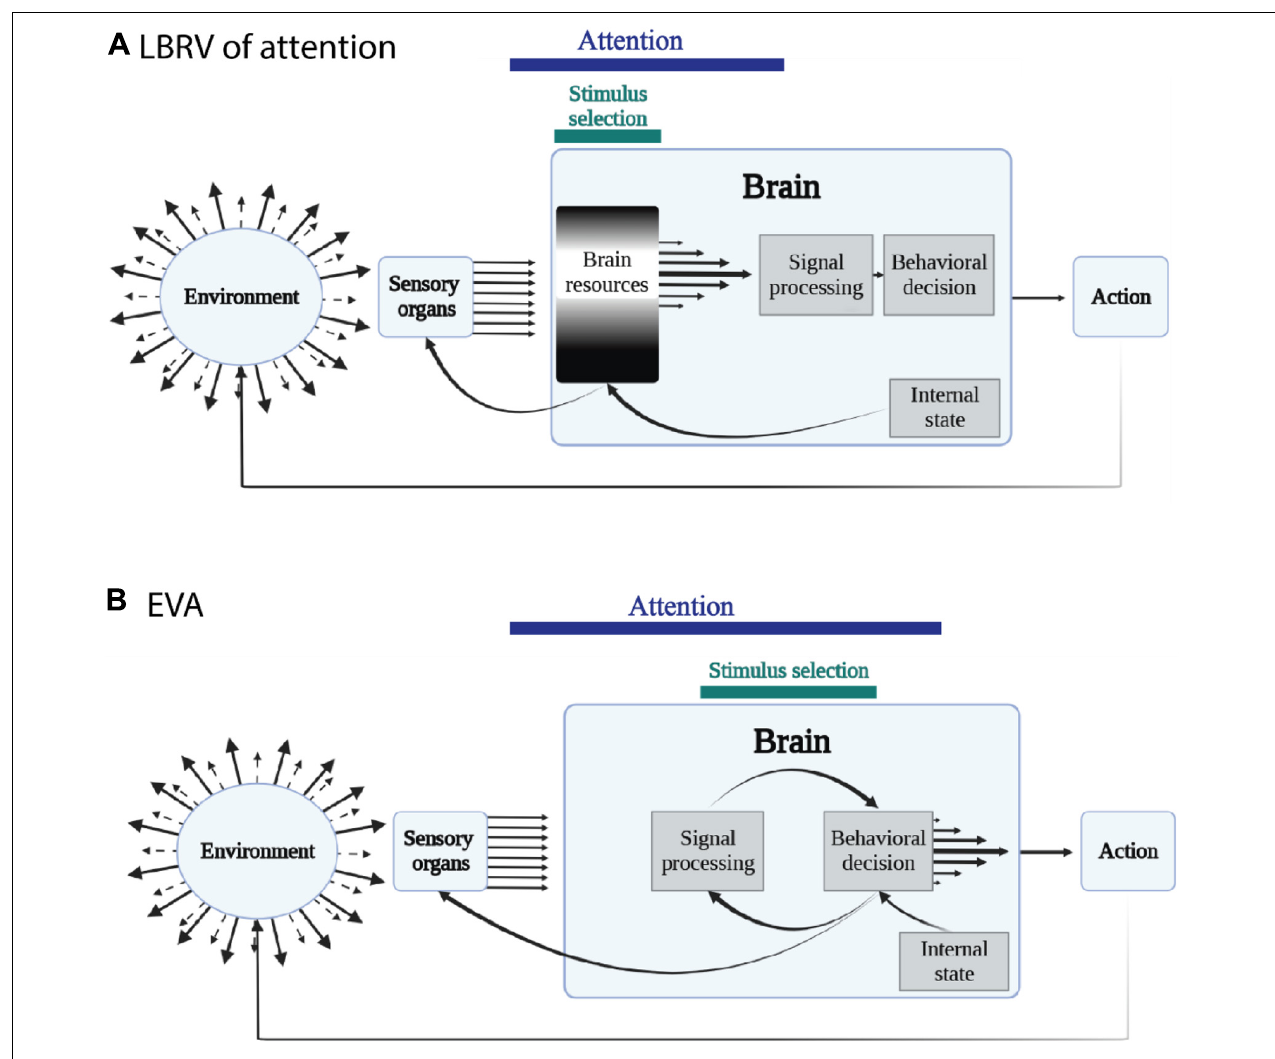
FIGURE 2 | Comparison between the hypothesized environment-to-behavior pathways under the LBRV and under the EVA. (A) Under the classical LBRV of attention, the abundant and rich information in the environment is sub-sampled by the sensory organs and transmitted to the brain. In the brain, a limited resource (white shading) is allocated to process selected and filtered information for behavioral choice which guide actions that feed back to the environment. The selection process is affected by the internal state which includes motivations, tasks etc. The selection process can also influence the sensory organs (overt attention) or not (covert attention). (B) Under the EVA scheme, information from the environment is sub-sampled and transmitted to the brain, where it is used to make a decision of the target of behavior. The decision then feed back to enhance representations of signals that lead to target oriented behaviors, and to reduce representations of signals that lead to distracting behaviors (covert attention). In some cases the decision influences the sensory organs (overt